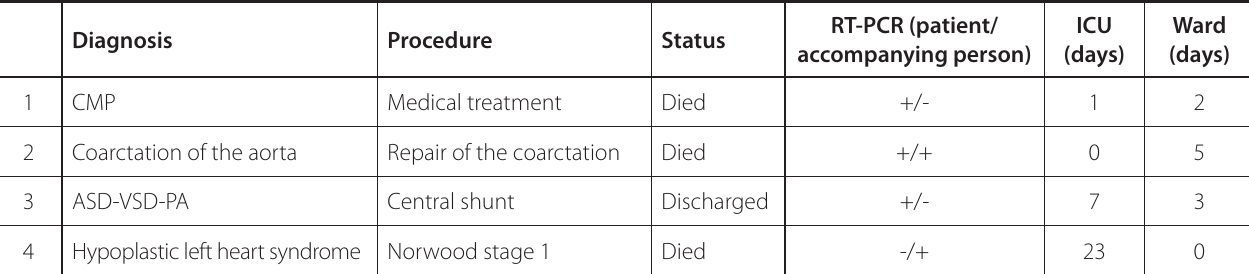
Table 1 . Patients and their accompanying persons with positive COVID-19 RT-PCR test